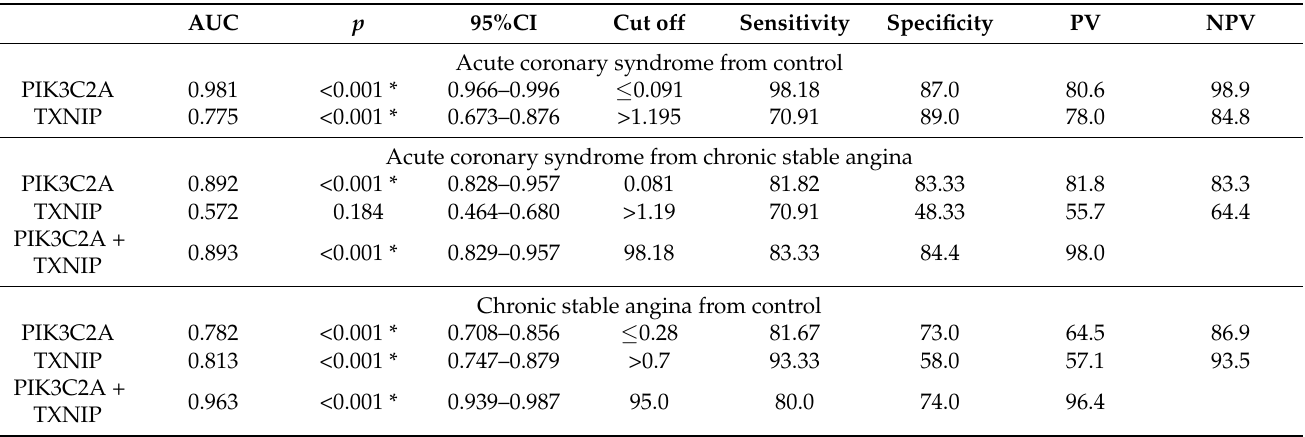
Table 1. Comparison of the involved groups based upon demographic and clinical parameters.